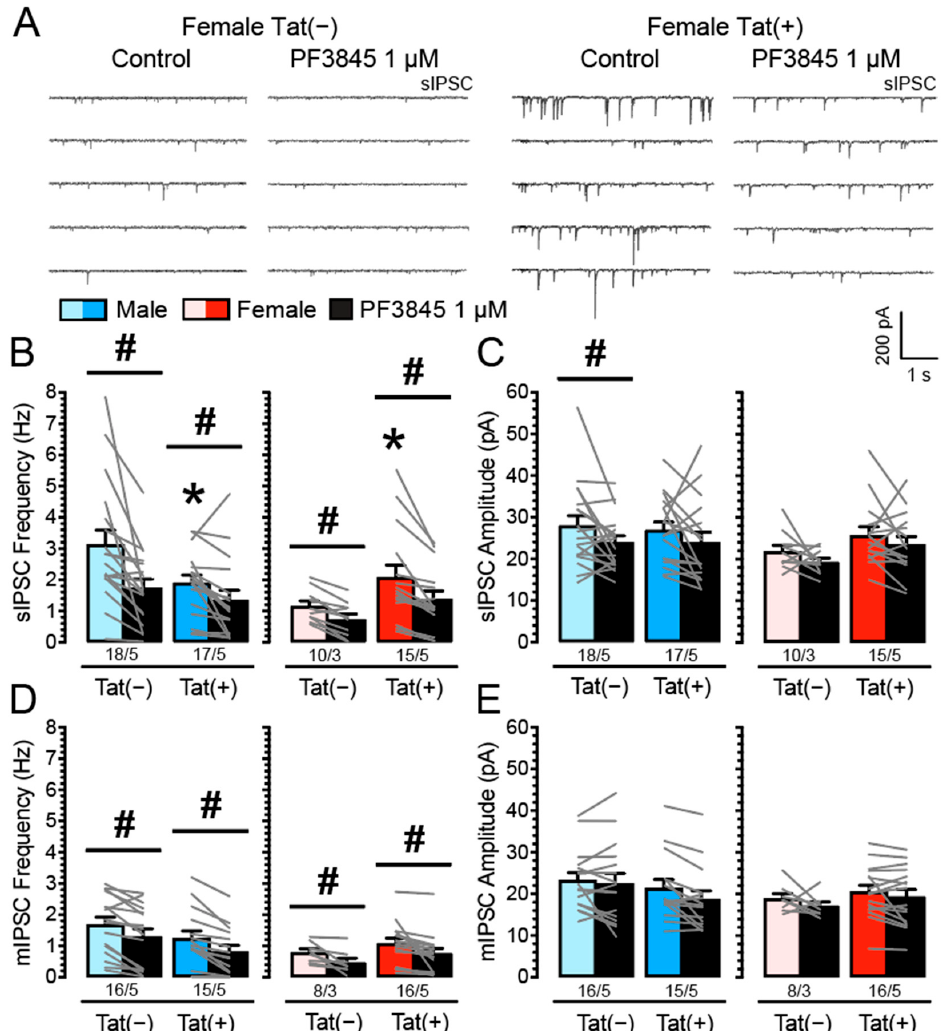
Figure 2. PF3845 decreases the frequency and partially the amplitude of IPSCs in mPFC neurons independent of Tat induction and sex. ( A ) Representative traces show sIPSCs in female Tat( − ) and Tat(+) mPFC brain slices before and after PF3845 (1 μ M) application. ( B ) Tat(+) males showed decreased sIPSC frequency compared to Tat( − ) males, whereas Tat(+) females demonstrated increased sIPSC frequency compared to Tat( − ) females. Further, PF3845 significantly decreased the mean sIPSC frequency in Tat( − ) and Tat(+) brain slices for each sex with the downregulation being similar across all groups. ( C ) For the mean amplitude of sIPSCs, a significant downregulating effect by PF3845 was noted specifically for Tat( − ) males. ( D ) For the mean mIPSC frequency, PF3845 significantly decreased mIPSC frequency in all groups with similar inhibitory effects across. ( E ) For the mean